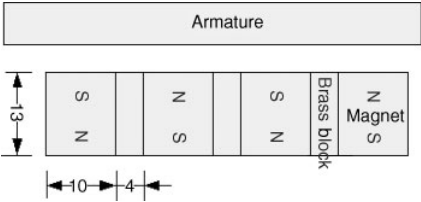
Figure 6 Type B structure of the magnetic unit.